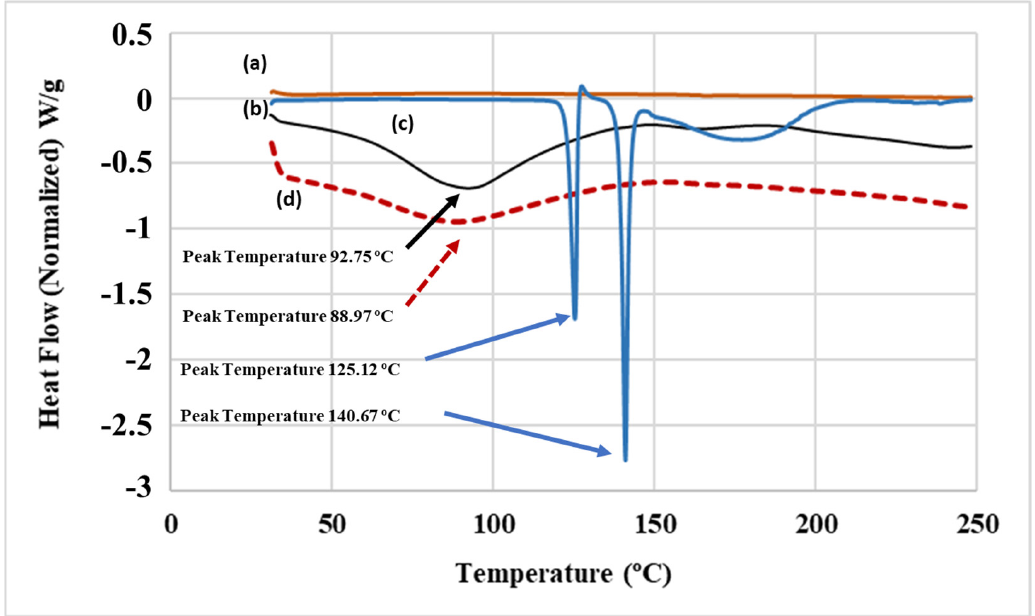
Figure 5. DSC curves for ( a ) fluticasone propionate (FP), ( b ) salmeterol xinafoate (SAL), ( c ) (FP- SAL/Lys-PA) NCs and ( d ) Lys-PA.